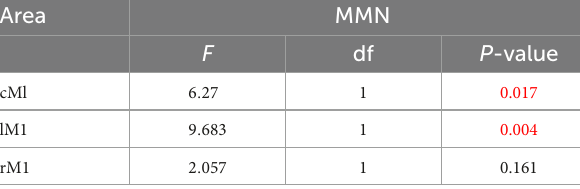
TABLE 2 The statistical analysis result of MMN.